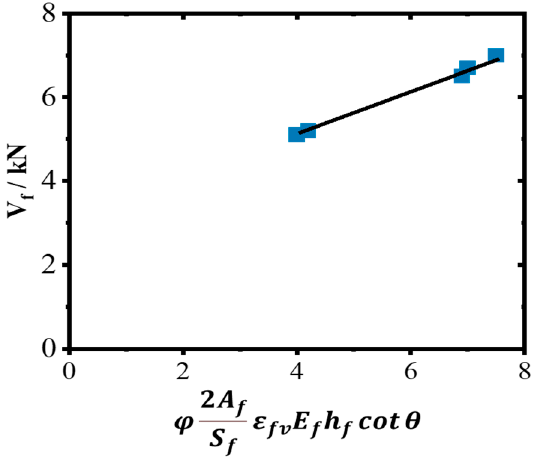
Figure 9. Utilization of GFRP .